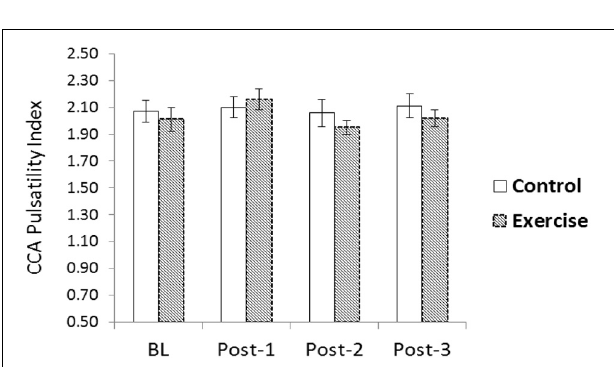
FIGURE 3 | Change in common carotid artery (CCA) β -stiffness index following acute resistance exercise (RE) vs. a time control condition. A significant condition-by-time interaction was detected for (CCA) β -stiffness index ( p < 0 . 05). β -stiffness index was elevated 10, 20, and 30-min after exercise compared to baseline ( p < 0 . 05) ∗ .